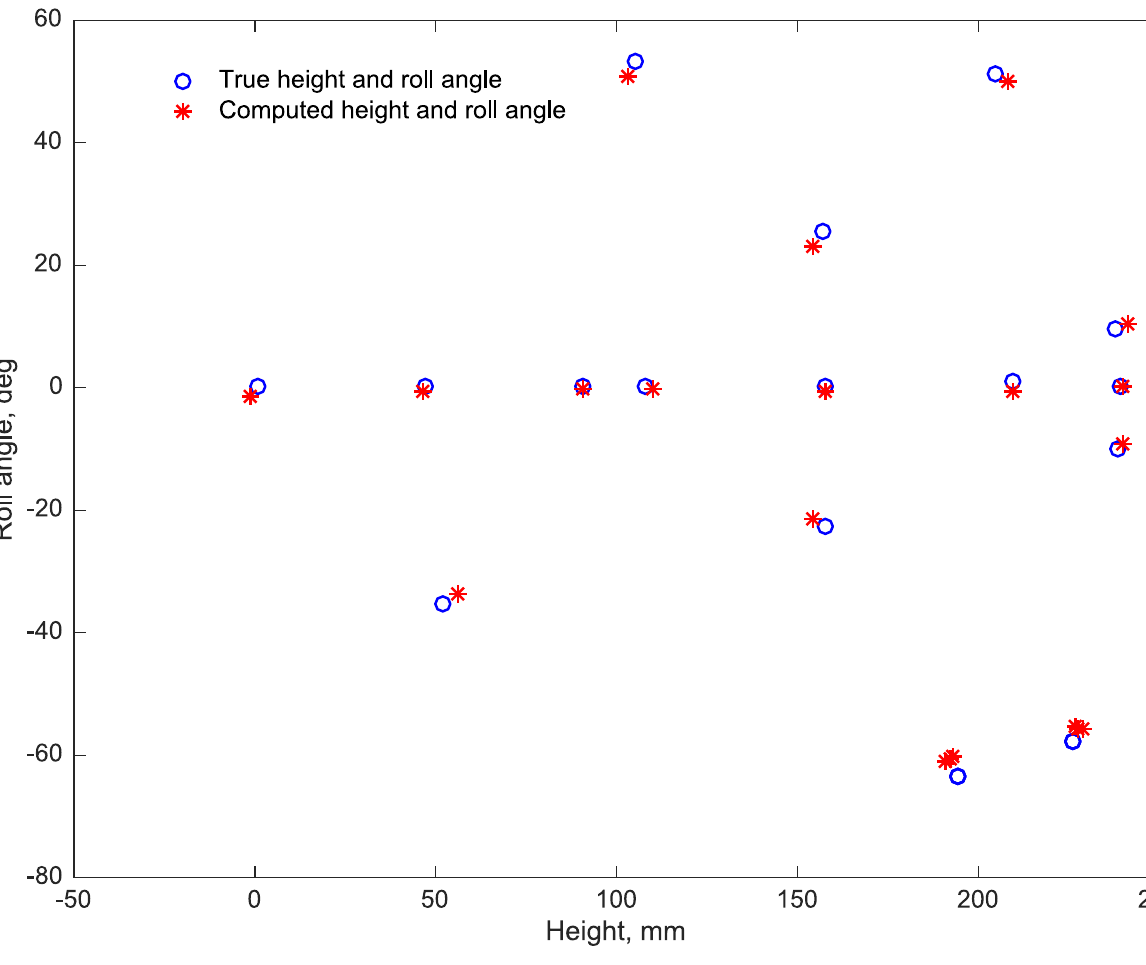
Fig 13. Comparison of true thorax heights and roll angles with their computed values. In these test examples the model bird was positioned at 20 different 3D locations within the arena, facing various directions, and at different heights and roll angles.